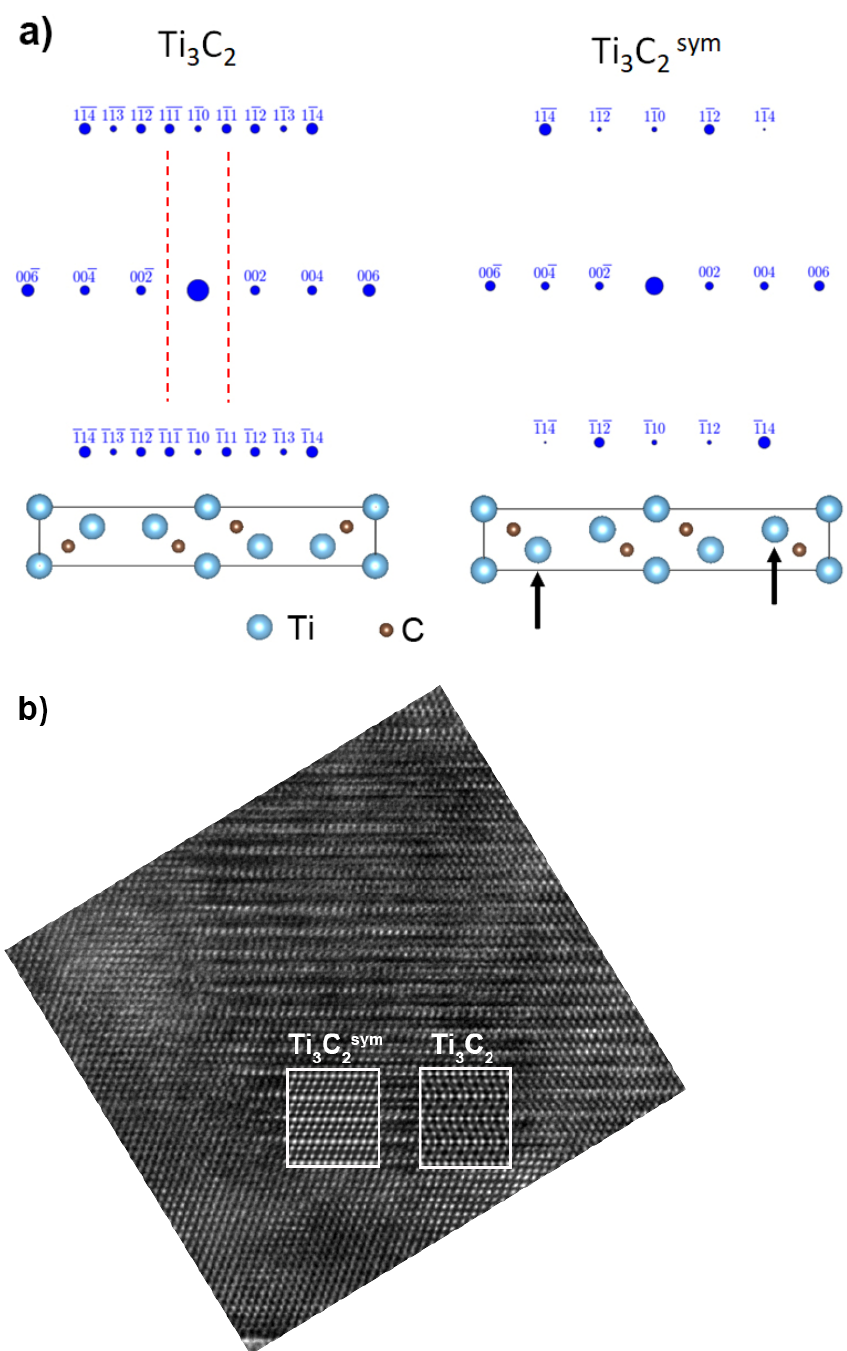
Figure 10. Simulation of Ti 3 C 2sym structure formation: ( a ) The way of performing simulation visual- ized using VESTA (ver. 3.5.7) (National Museum of Nature and Science, Tsukuba-shi, Japan) [30], ( b ) comparison of Ti 3 C 2 and Ti 3 C 2sym structures to the structure obtained in the experiment.